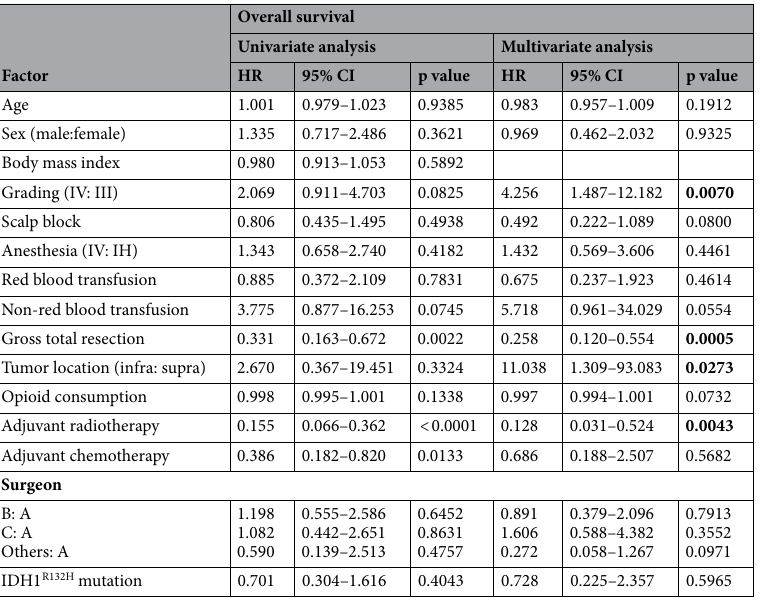
Table 3. Risk factors of worse overall survival. IV intravenous anesthesia, IH inhalational anesthesia, supra supratentorial, infra infratentorial, IDH isocitrate dehydrogenase.